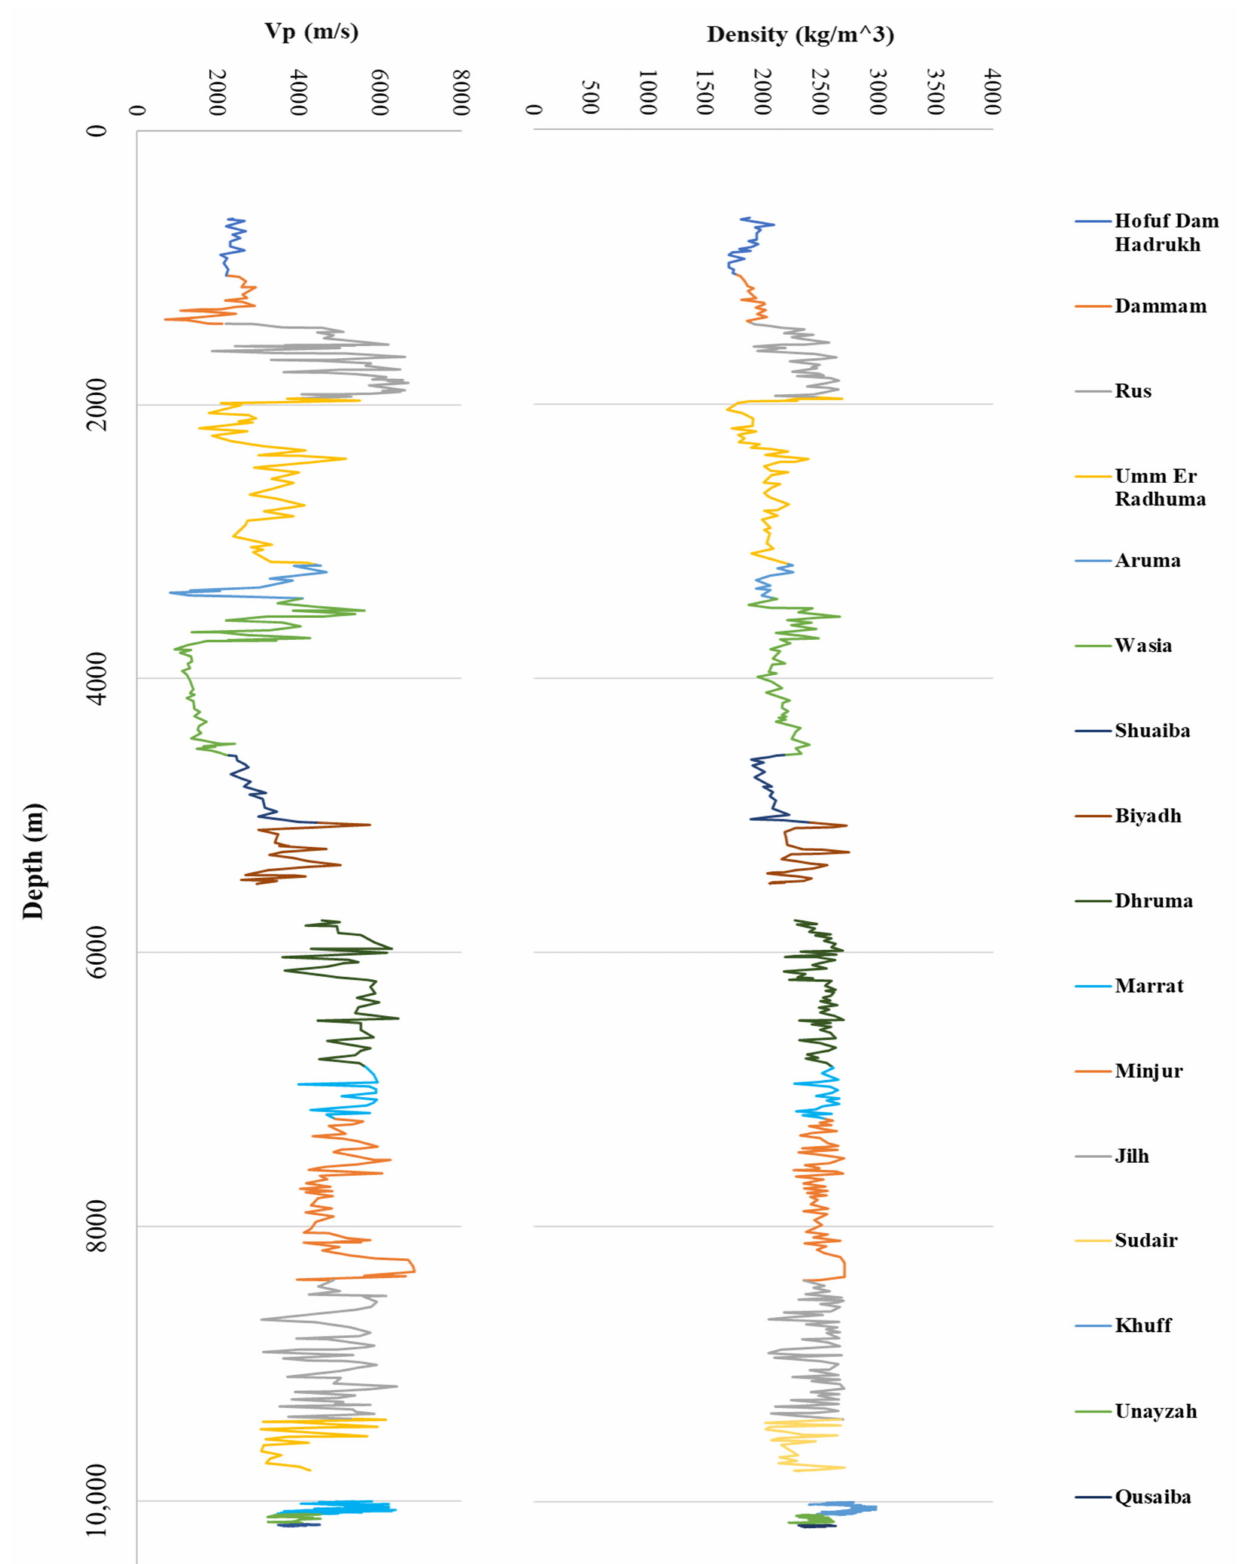
Figure 4. V p and ρ plot of selected formations